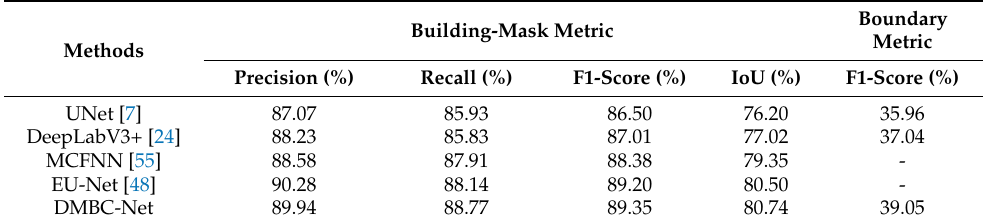
Table 3. Quantitative comparison on the Inria Aerial Image Labeling data set.